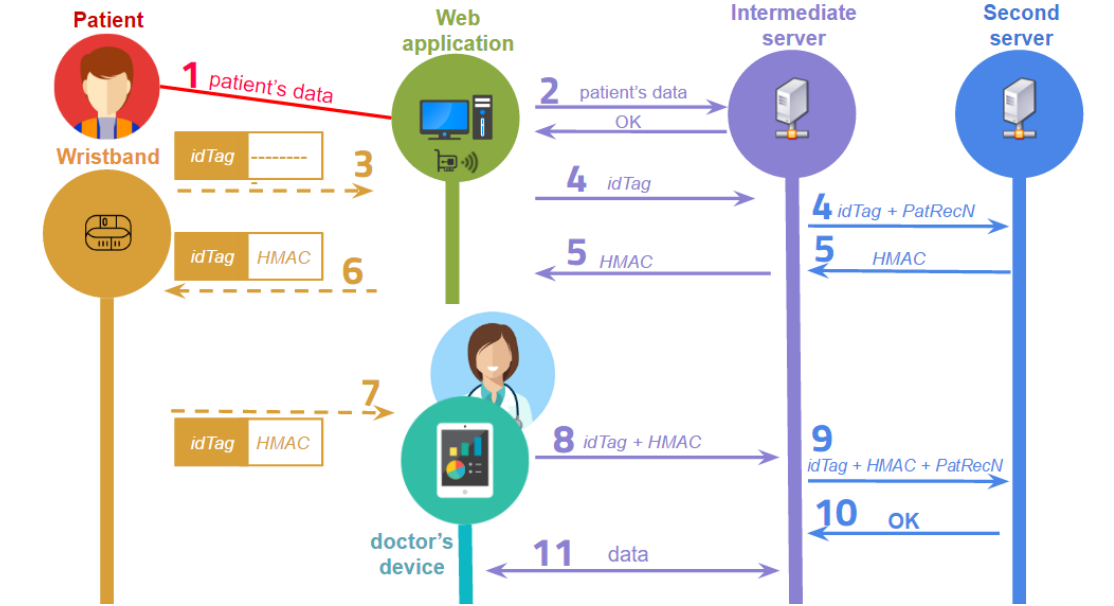
Figure 2. Medical record